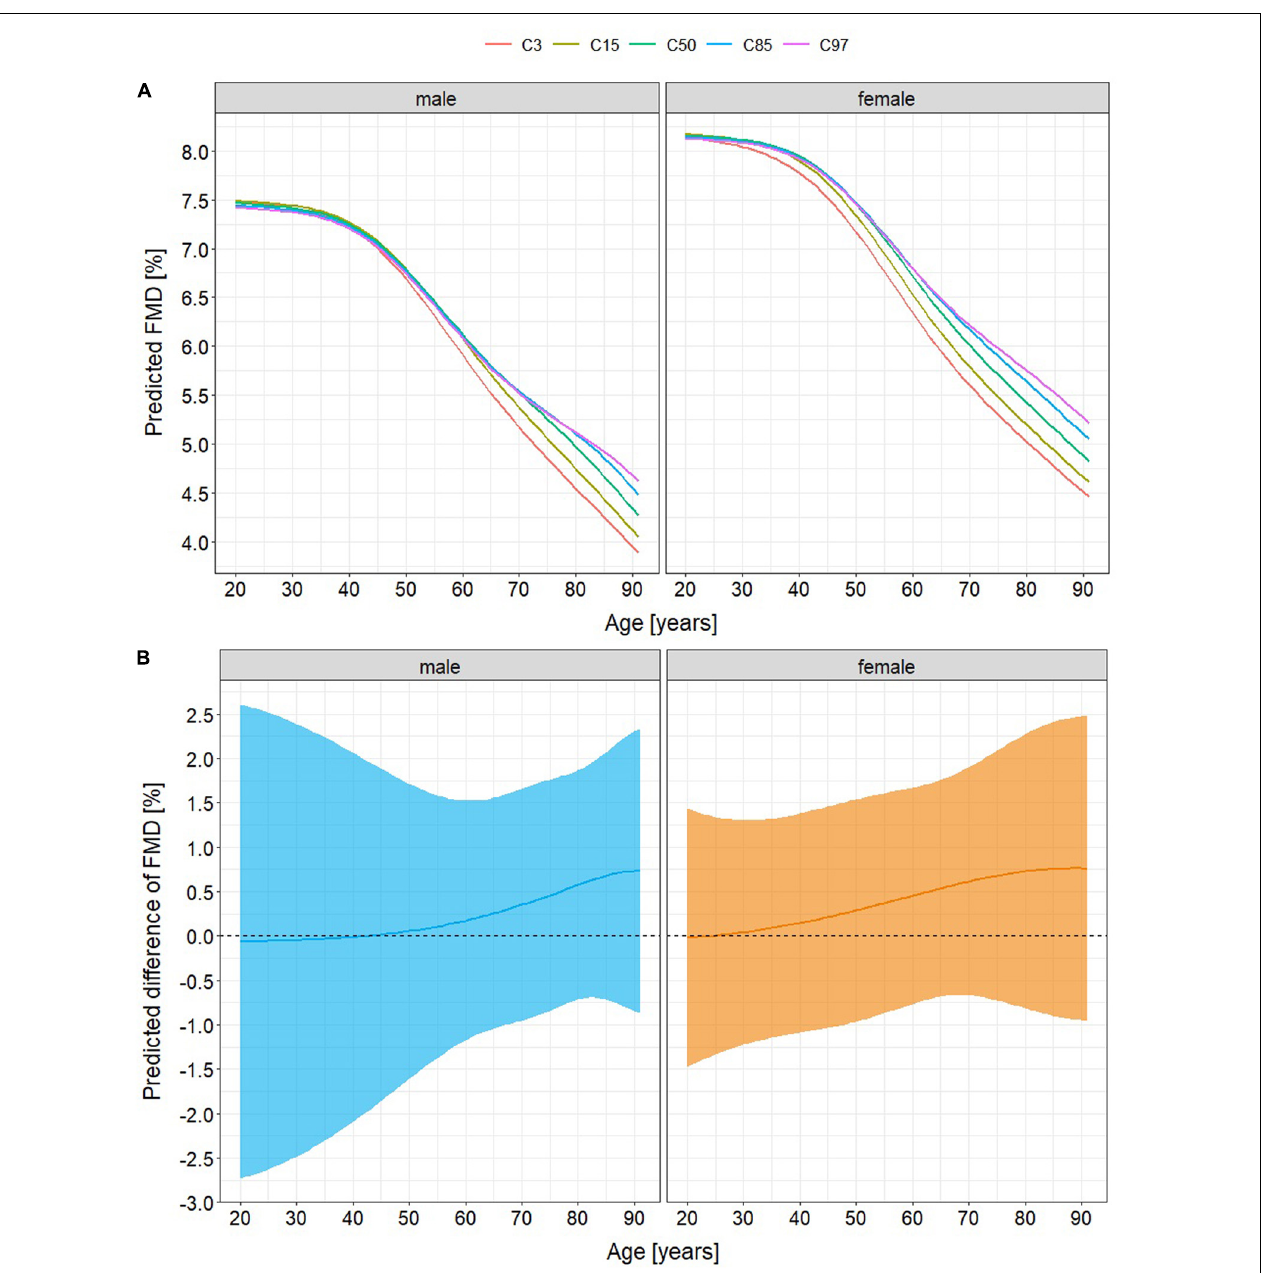
FIGURE 2 | Age-related differences of flow-mediated vasodilation (FMD) in healthy adults (A) stratified by percentile of peak oxygen consumption (˙VO 2 peak) and (B) predicted difference between FMD in the lowest-fit (˙VO 2 peak ≤ 3rd percentile) and FMD in the highest fit (˙VO 2 peak ≥ 97th percentile) individuals. There are no differences associated with cardiorespiratory fitness until the age of 30 (women) and 50 years (men). Afterward, models predict a lower FMD at old age of 7% in very low-fit men (maximum age-related difference of 41% if ˙VO 2 peak ≥ 97th percentile versus 48% if ˙VO 2 peak ≤ 3rd percentile) and of 9% in very low-fit women (36% versus 45%). Absolute mean differences of FMD between ˙VO 2 peak percentiles ≤ 3rd versus ≥ 97th deviate from 0 in tendency at middle and old age (maximum 0.75%, 95% confidence intervals –0.8 – 2.3% (men) and –1.0 – 2.5% (women)). C3, 15, 50, 85, and 97 = ˙VO 2 peak percentiles (3rd, 15th, 50th, 85th, and